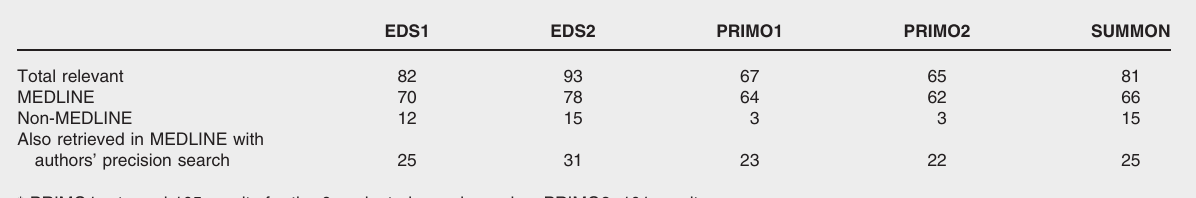
* PRIMO1 returned 105 results for the 6 evaluated search queries; PRIMO2, 101 results.